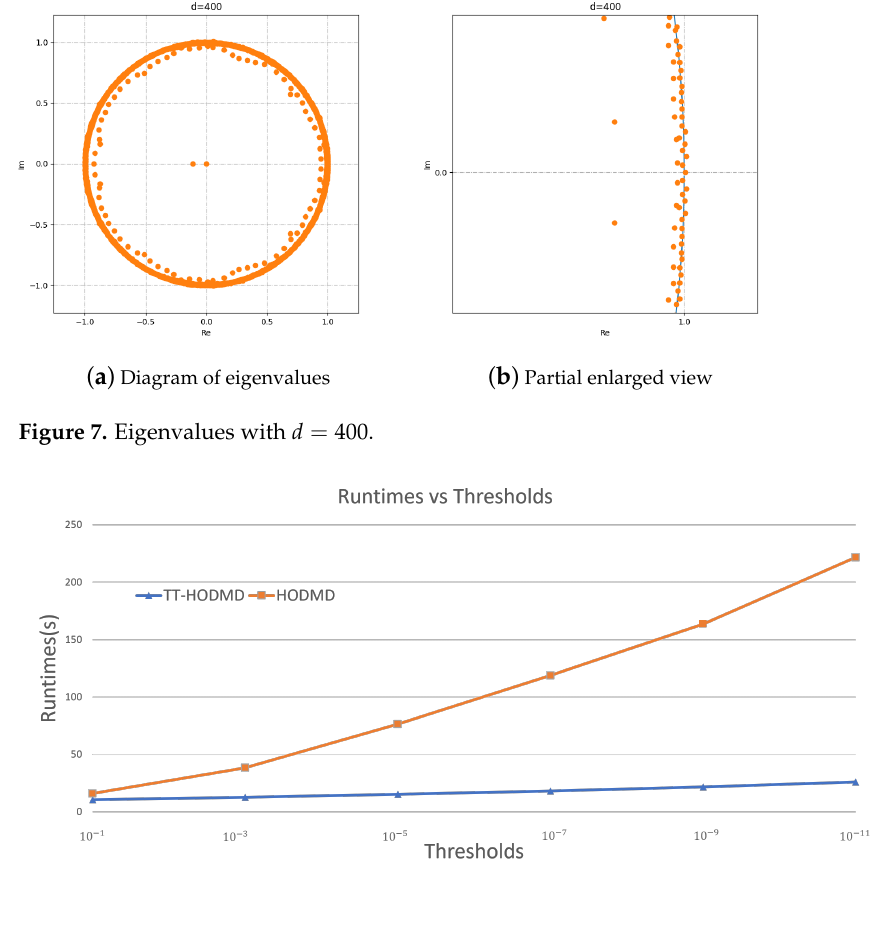
Figure 8. Runtime of HODMD and TT-HODMD applied to given STLF system based on d = 400 for different values of ε 0 .